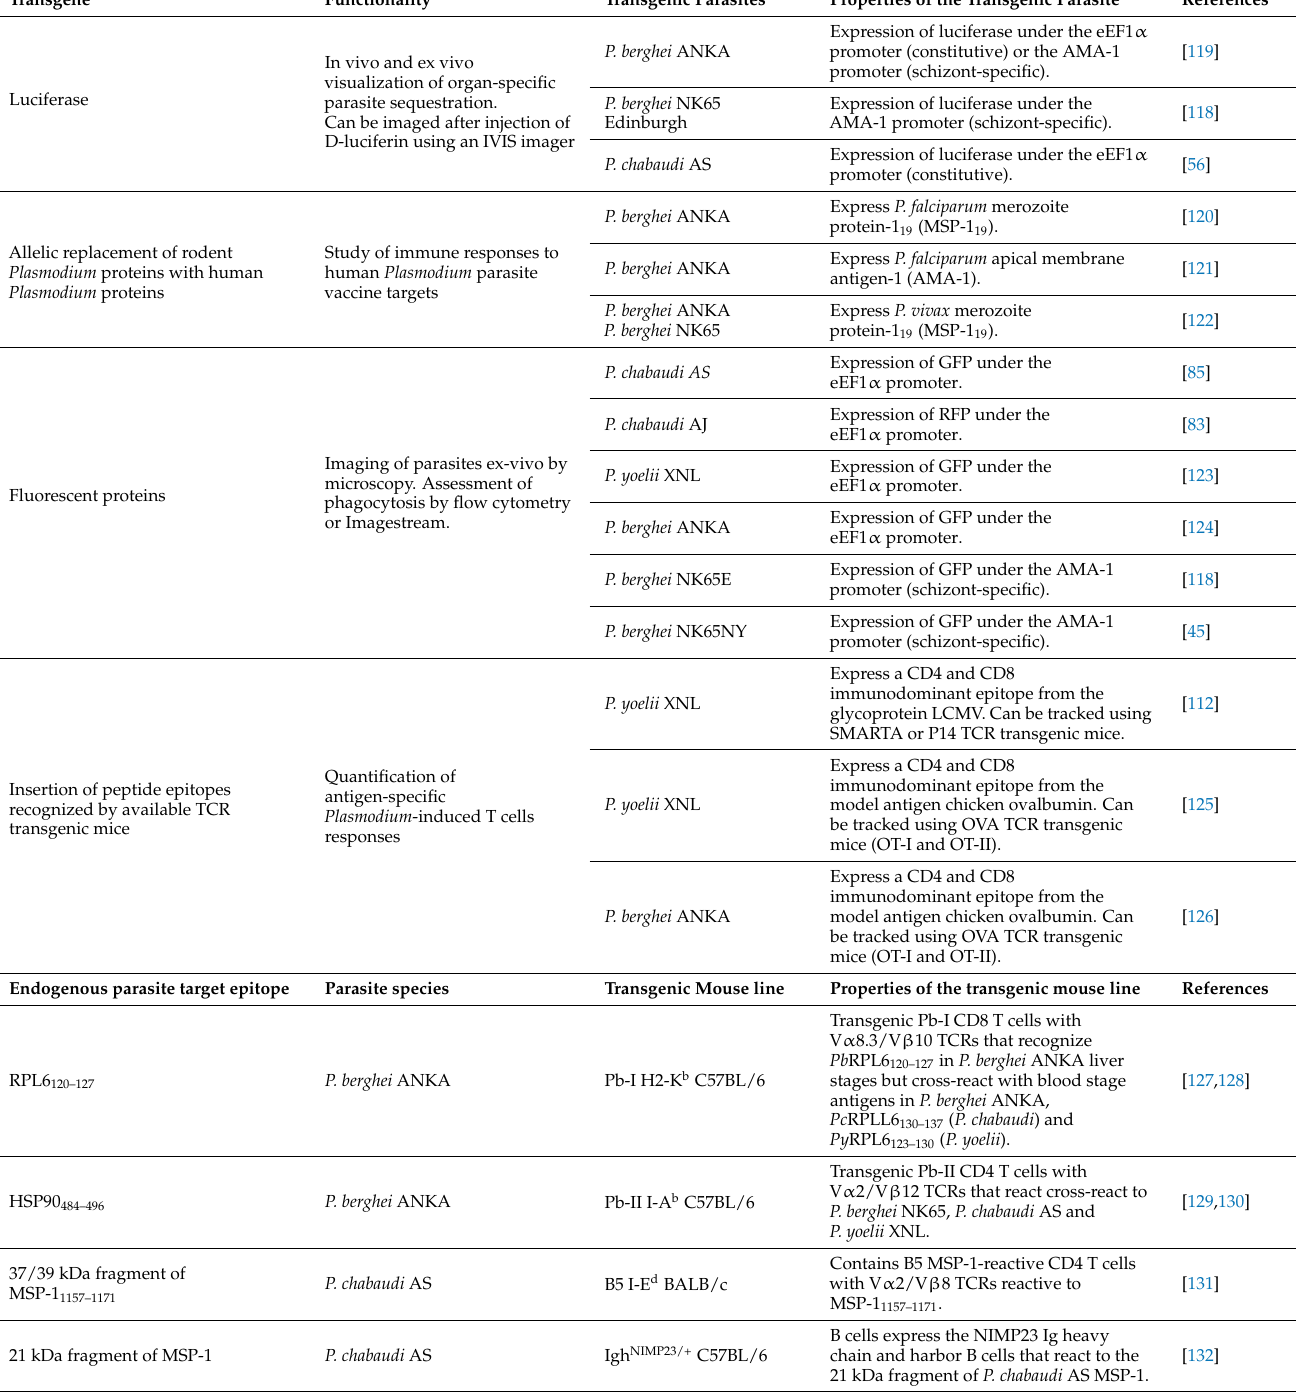
Table 4. Functionality of selected transgenic rodent Plasmodium parasites and mouse lines available to study of the immune response to Plasmodium -iRBCs. Repositories of rodent malaria strains available for use include the Rodent Malaria genetically modified Data Base (RMgmDB) (https: //www.pberghei.eu/index.php), the European Malaria Reagent Repository (bank: http://www. malariaresearch.eu/) and the Malaria Research and Reference Reagent Resource Center (MR4)